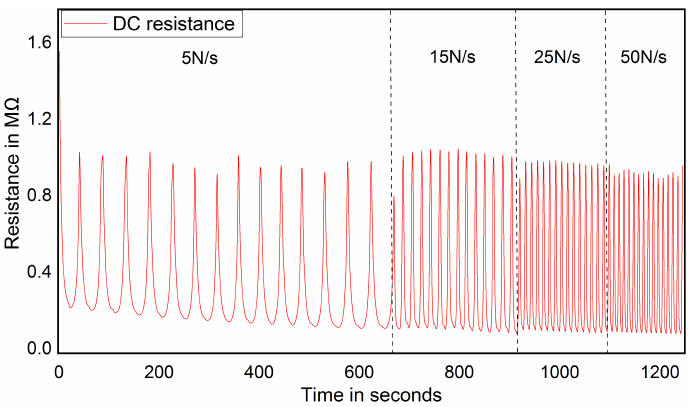
Figure 7. Sensor response on different rate of